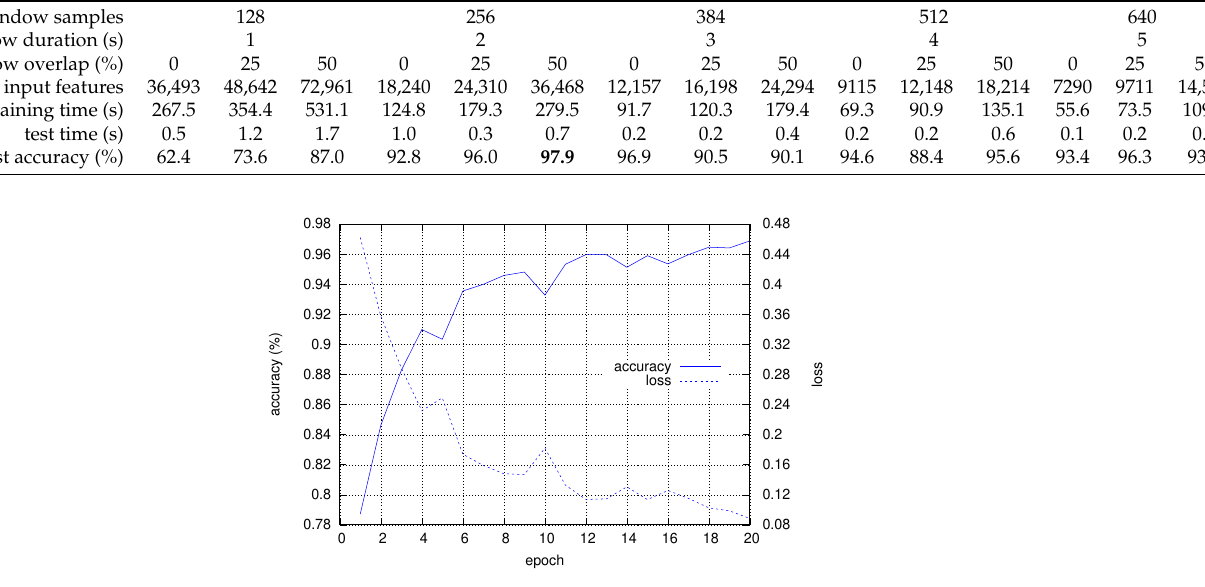
Figure 7. Accuracy and loss progress for validation data with respect to training epochs.